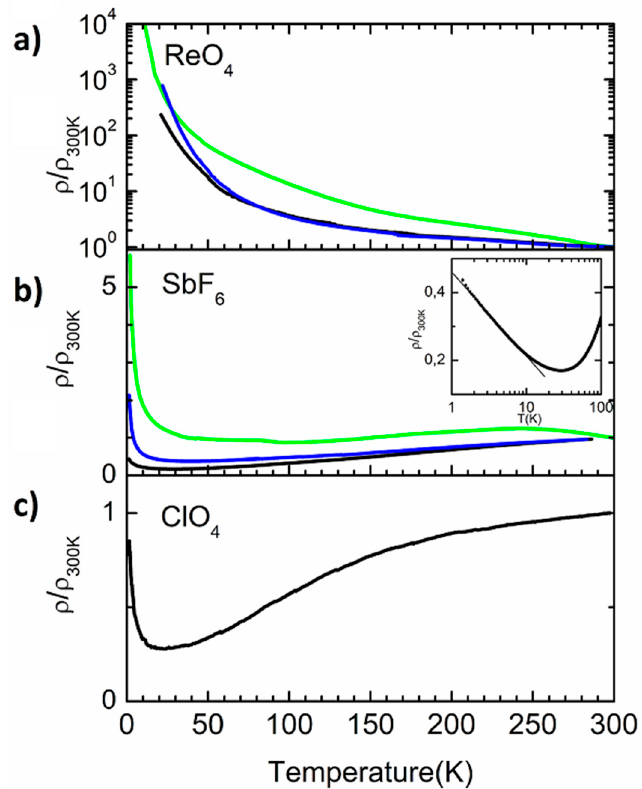
Figure 3. Temperature dependence of the electrical resistivity ρ measured in di ff erent crystals along their main crystal axis of (CNB-EDT-TTF) 4 ReO 4 ( a ), (CNB-EDT-TTF) 4 SbF 6 ( b ), and (CNB-EDT-TTF) 4 ClO 4 ( c ). The inset in ( b ) shows the low temperature data plotted as a function of log T. The diferent colors in ( a , b ) show the diferent resistivity beahviour specially at low temperatures for for 3 diferent samples.